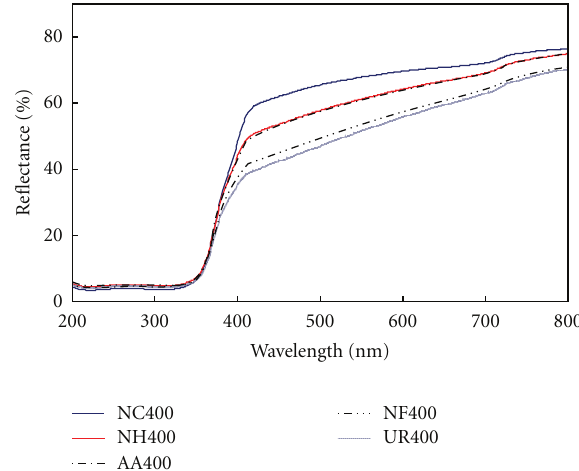
Figure 2: UV-Vis-DRS spectrum of the samples prepared in di ff erent nitrogen compounds (NF400:NH 4 F; NH400:NH 3 ; NC400:NH 4 HCO 3 ; AA400:NH 4 OOCCH 3 ; UR400:CH 4 N 2